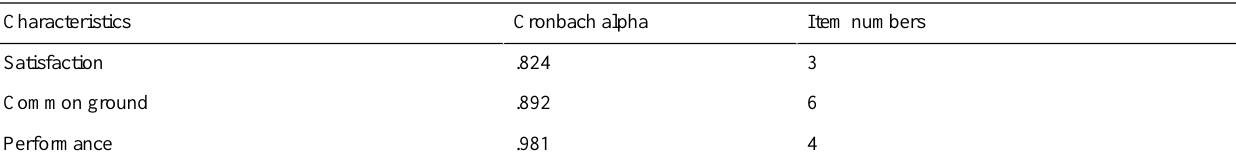
Table 8. Subscale reliability